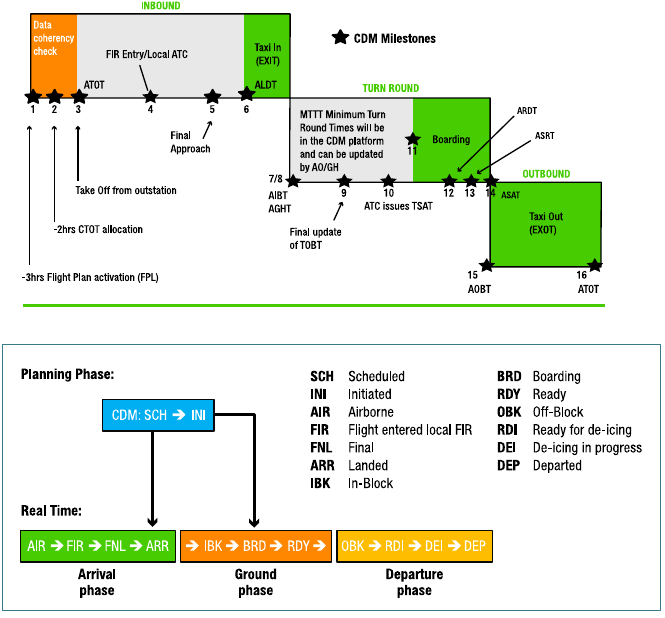
Figure 2. The milestone approach and its nomenclature. Source [1].